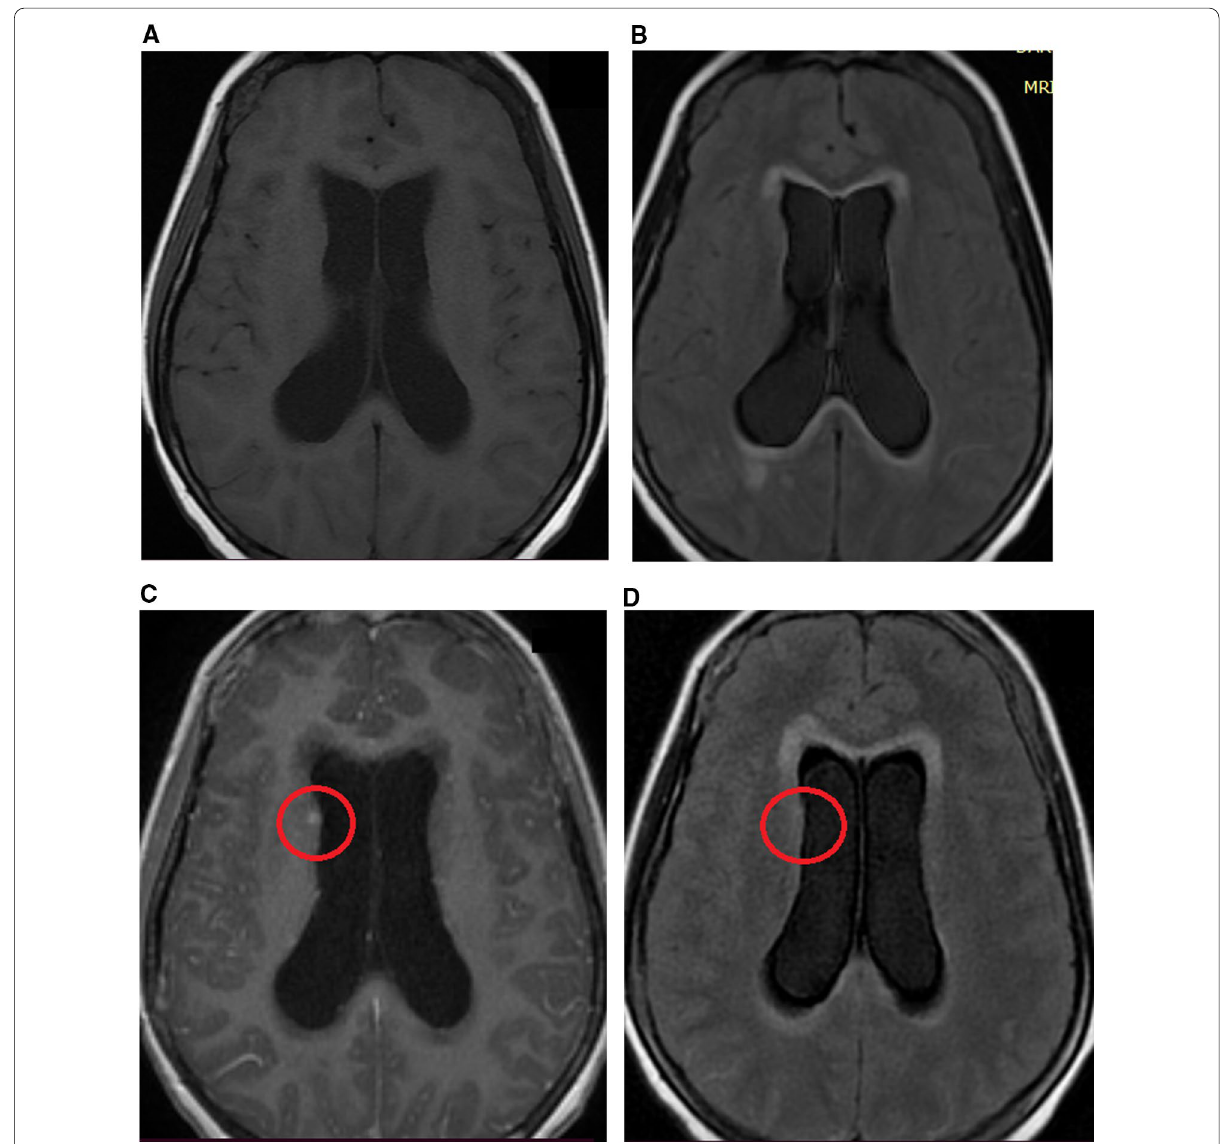
Fig. 3 Female patient aged 28 years with known breast cancer. MRI study of the brain revealed subependymal tiny nodule noted at the right lateral ventricle, that shows enhancement on the CE-T1WI (C) but no enhancement detected on DPC-FLAIR (D). A Axial pre-contrast T1WI. B Axial FLAIR. C Axial CE-T1WI. D Axial